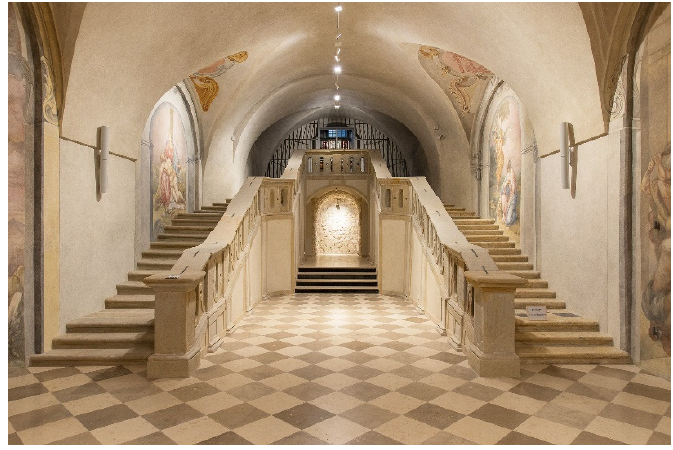
Figure 1. A general view of the Holy Stairs in the monastery of the Piarists in Cracow. Condition following conservatory work in 2017–2020.